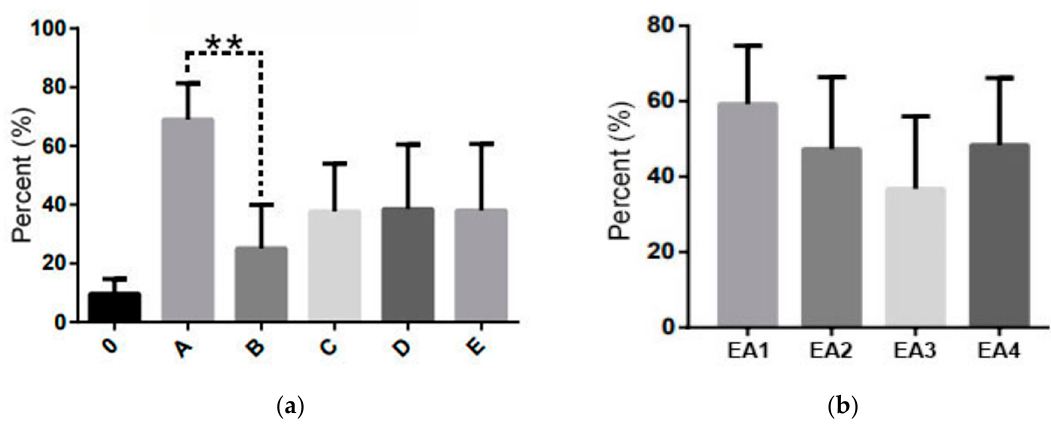
Figure 6 . Treatment efficacy of varroacides with different active ingredients; ( a ) treatments; ( b ) Figure 6. Treatment e ffi cacy of varroacides with di ff erent active ingredients; ( a ) treatments; ( b ) locations; locations; ** ( p < 0.05); mean ± SD. ** ( p < 0.05); mean ±